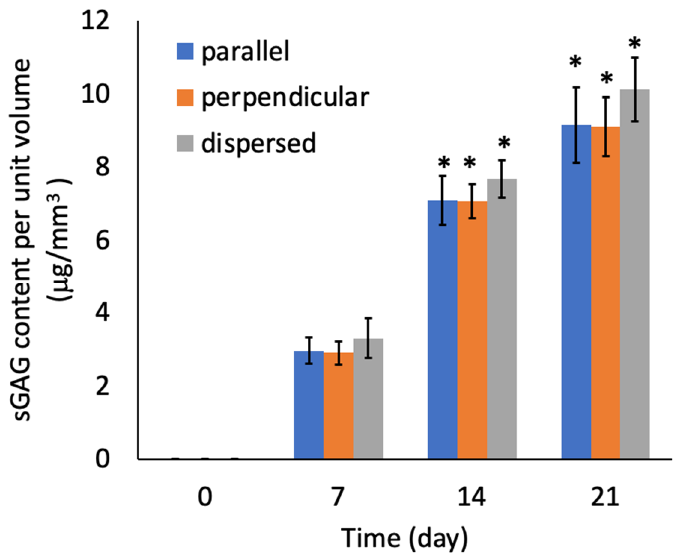
Figure 11. Sulfated GAG content of the agarose gel-sheet constructs cultured for 21 days. Mean +/− S.D., n = 5. * indicates a significant difference in each value compared to day 7, p <